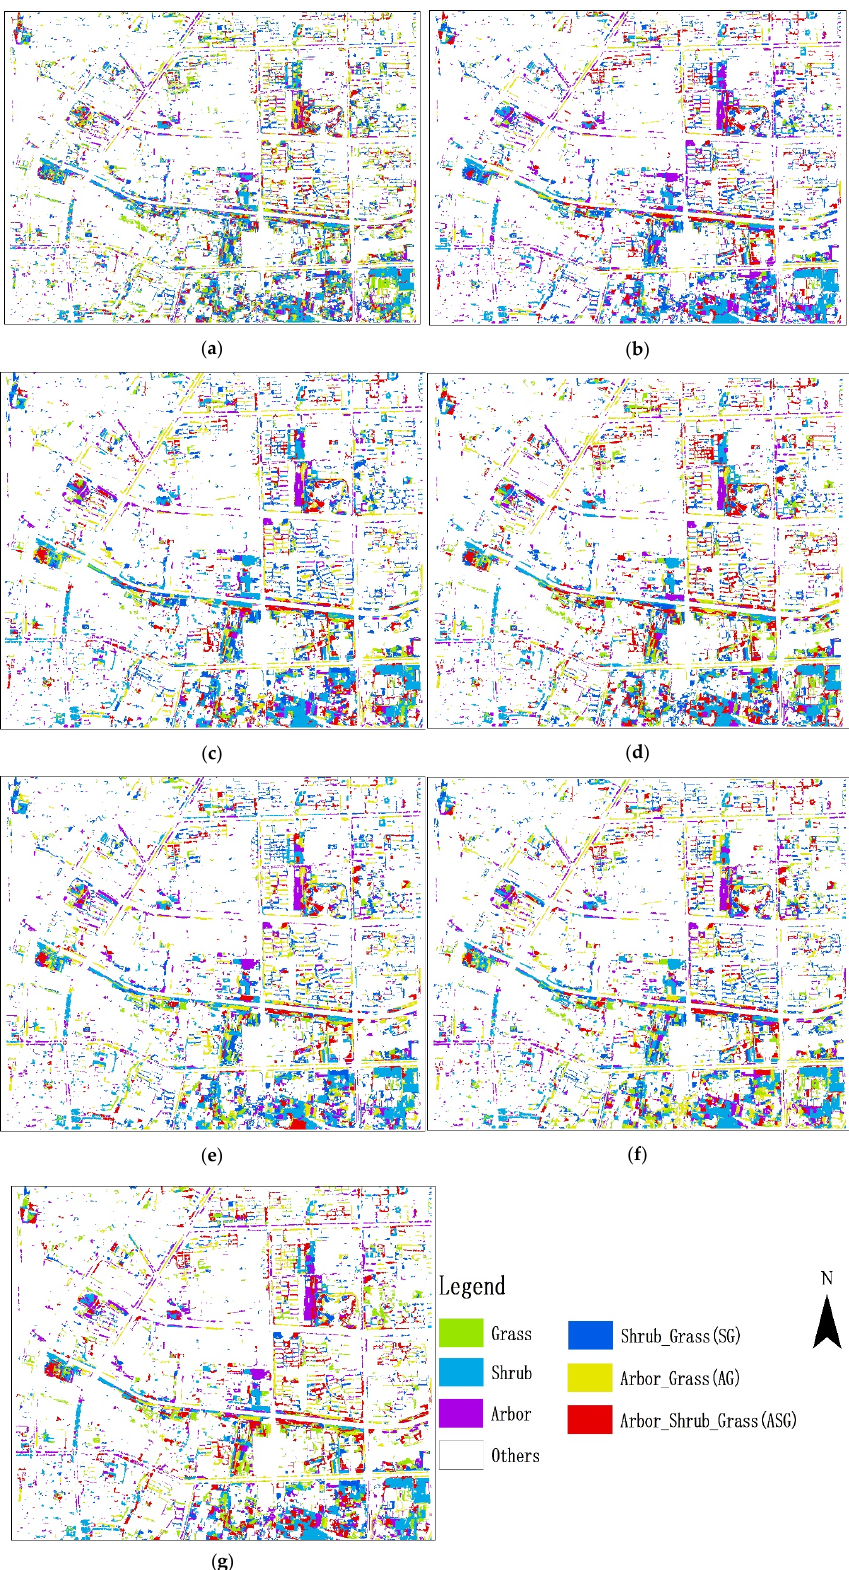
Figure 5. Classification map of urban vegetation types in Lianyungang based on different CLBP window textures, using only spectral information ( a ) and combining spectral information with CLBP window texture in Lianyungang at 3 × 3 ( b ), 5 × 5 ( c ), 7 × 7 ( d ), 9 × 9 ( e ), 11 × 11 ( f ), and 13 × 13 ( g ).